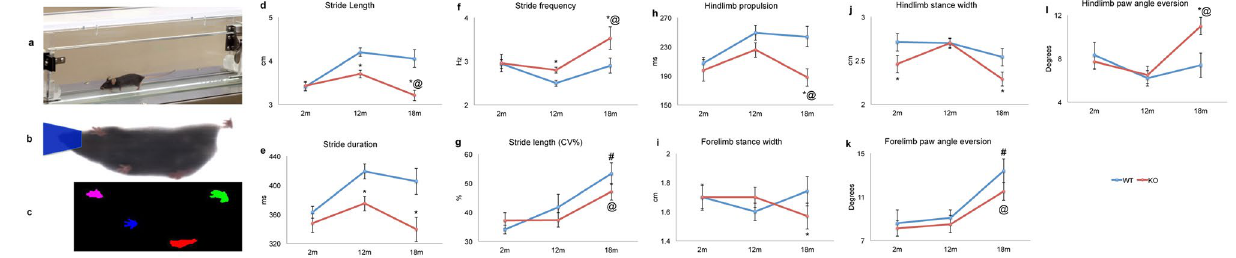
Figure 1. DigiGait analysis of young, middle-aged and old WT and Fgf2KO mice. To assess whether knockout of the Fgf2 gene resulted in alteration in gait, treadmill exhaustion test ventral plane videography (DigiGait, Mouse Specifics, Inc., Quincy, MA) was performed. ( a – c ) DigiGait related images. ( a ) Lateral view of the mouse containment area around the treadmill belt. ( b ) Representative image of mouse from the camera position below the transparent treadmill belt. The blue area is added during video analysis to nullify any background generated by the nose. ( c ) Representative image from the DigiGait software displaying the remaining pixels representing paw contact with the belt utilized for gait analysis. Gait analysis of young (2 months), middle-aged (12 months) and old (19 months) WT and Fgf2KO mice showed: ( d ) Stride length was significantly shorter in old Fgf2KO compared to old WT and middle-aged Fgf2KO. Middle-aged Fgf2KO was also significantly shorter than middle-aged WT. ( e ) Stride duration was significantly shorter in middle-aged Fgf2KO compared to middle-aged WT as well as in old Fgf2KO compared to old WT. ( f ) Stride frequency significantly was higher in old Fgf2KO compared to old WT and middle-aged Fgf2KO . Middle-aged Fgf2KO also showed significantly increased stride frequency compared to WT of the same age. ( g ) Stride variability (coefficient of variation) was higher in old WT compared to middle-aged WT as well as old Fgf2KO compared with middle-aged Fgf2 KO. ( h ) Hindlimb propulsion was significantly shorter in old Fgf2KO versus old WT and middle-aged Fgf2KO . ( i ) Forelimb stance width was significantly narrower in old Fgf2 KO versus old WT. ( j ) Hindlimb stance width was significantly narrower in old Fgf2KO versus old WT. ( k ) Forelimb paw angle eversion was similar in young and middle- aged WT and Fgf2KO mice and was increased in aged vs. middle-aged in both WT and Fgf2KO mice. ( l )